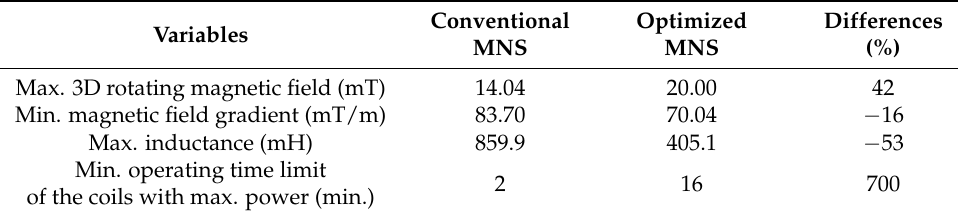
Table 5. Comparison of practical values between the optimized and conventional